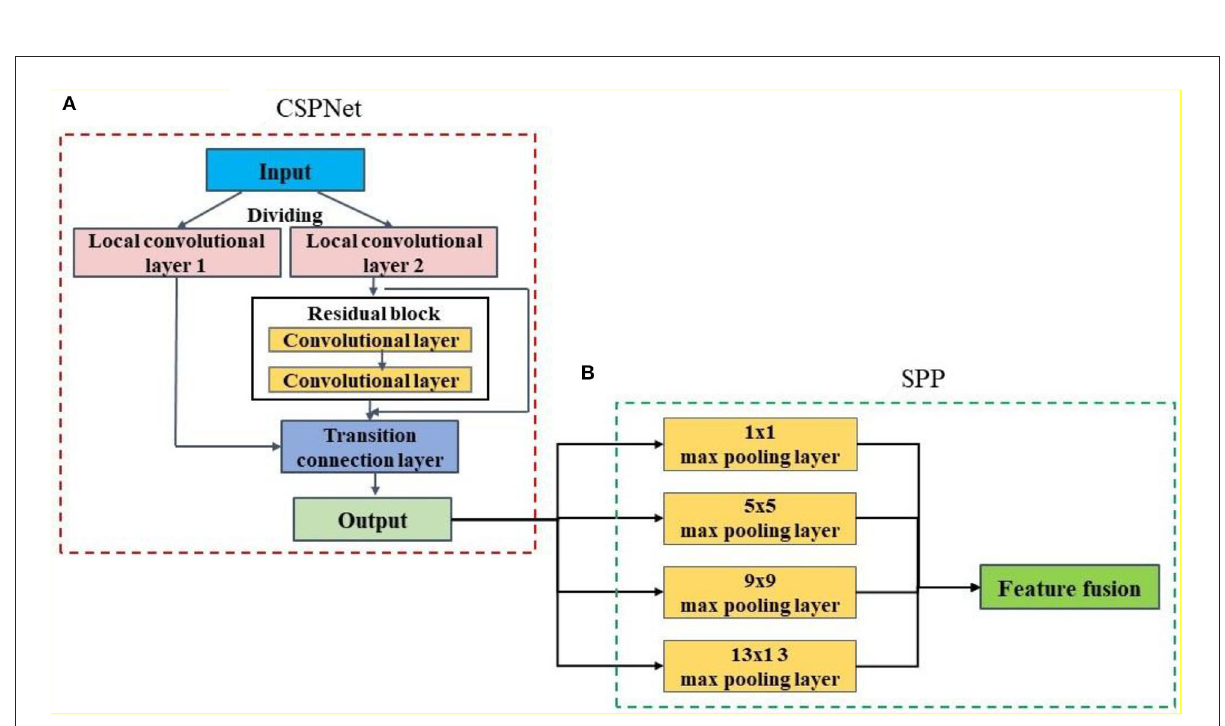
FIGURE4 Bottleneck network structure. (A) CSPNet module; (B) SPP